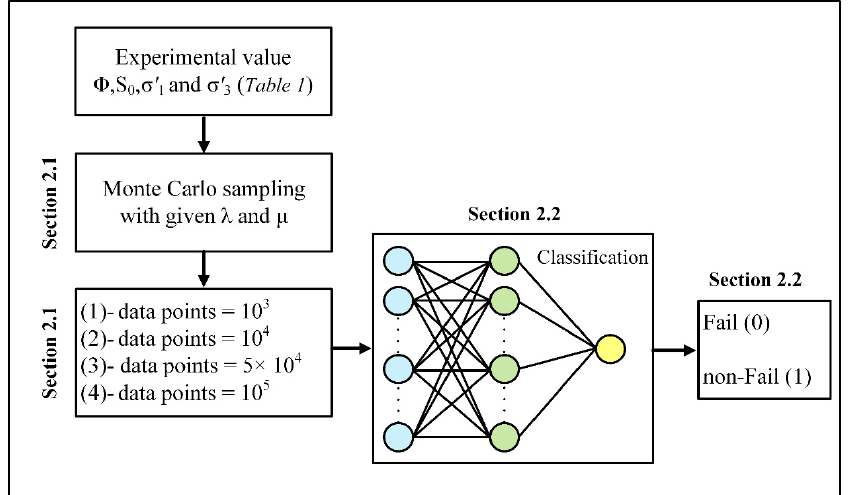
Figure 2. The diagram illustrates the overall work flow of this study in chronological order. The Monte Carlo method generates data points of four distinct sizes for strength parameters of friction angle ( φ ), cohesion (S 0 ) and effective stresses (i.e., σ ’ 1 , and σ ’ 3 ). Then, each data point with a specific size is sent into NN for classification.